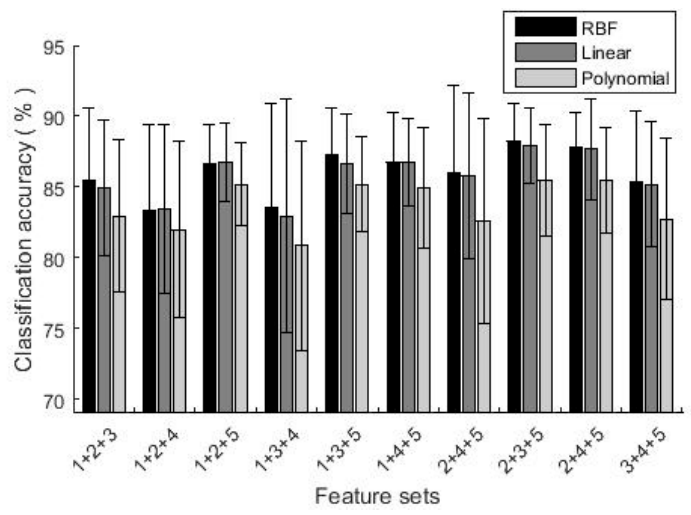
Figure 5. The classification accuracy using three feature sets.